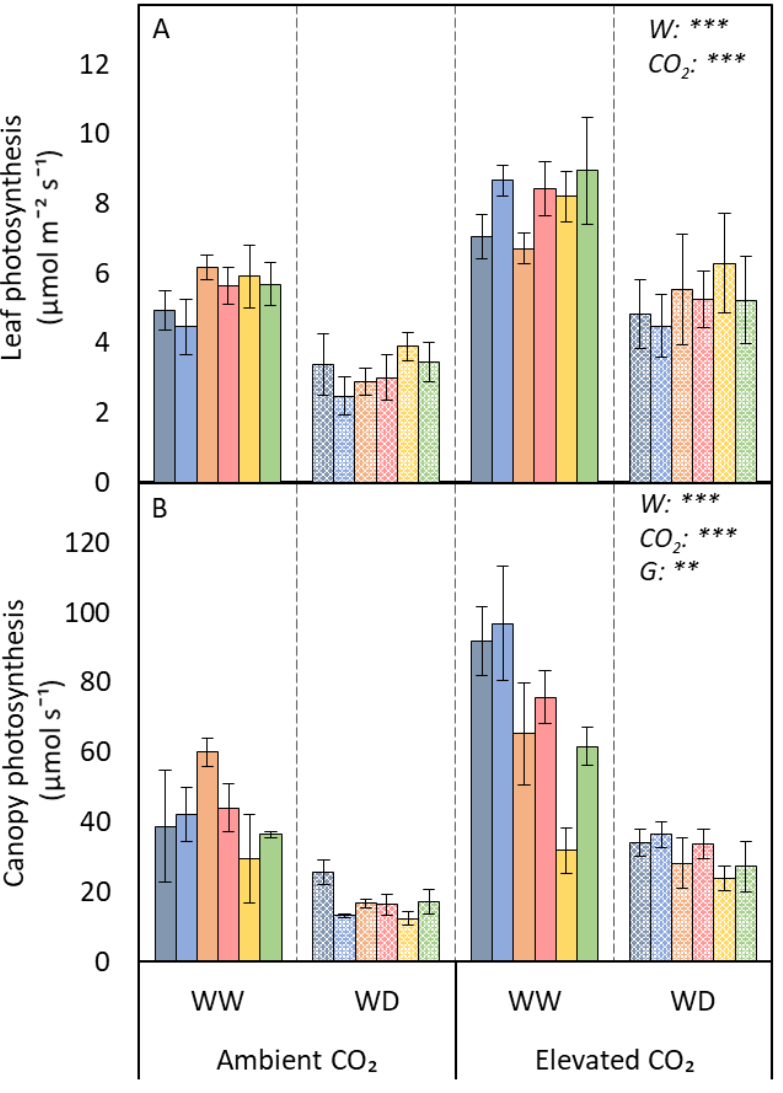
Figure 2. Leaf- ( A ) and canopy- ( B ) level photosynthesis measured on six genotypes of cacao grown at ambient and elevated CO 2 under well-watered (WW) and water deficit (WD) conditions. Error bars are standard error of the mean. Grey bars: CL 19/10; blue bars: ICS 1, orange bars: IMC 47; pink bars: POUND 7/B; yellow bars: SCA 6; green bars: SPEC 54/1. Where statistical differences were identified between the main factors these are noted on the top right of each plot. The asterisks indicate the factors which had a significant effect on each response variable (W: water treatment; CO 2 : CO 2 treatment; G: genotype; ** p < 0.01; *** p <